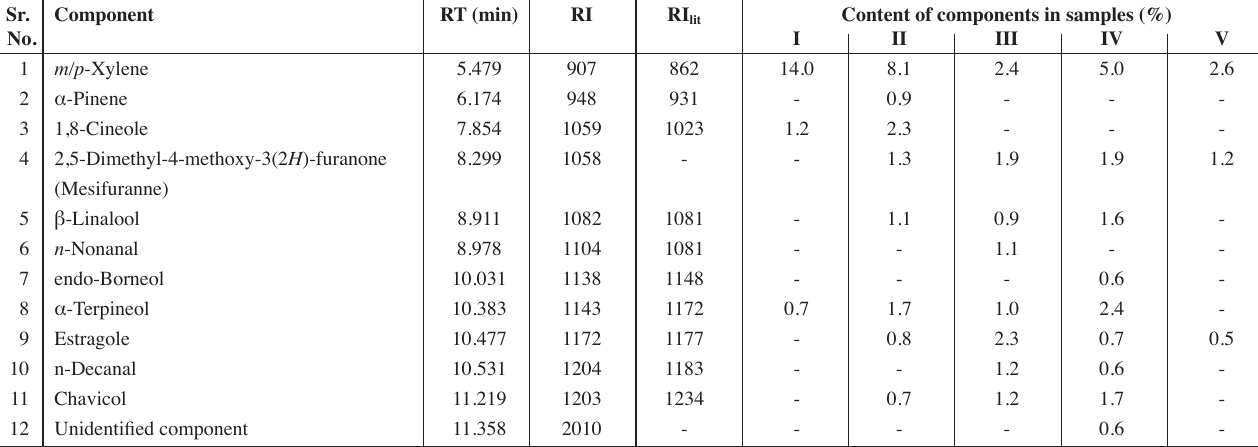
Tab. 3: Percentage composition of the essential oil from fruits of F. viridis Weston Sr.